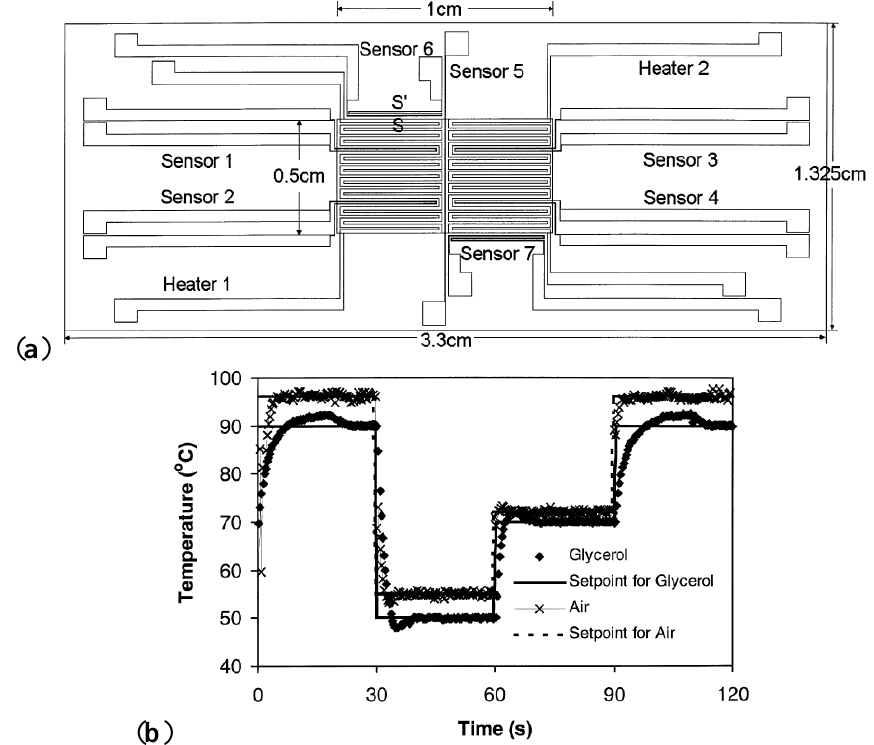
Figure 11. ( a ) Integration of platinum heaters (serpentine-like geometry) together with the integration of sensors. ( b ) Temperature response of the reaction chamber for different fluids, showing the gain scheduling control algorithm efficiency. Reprinted from [44], Copyright 2000, with permission from